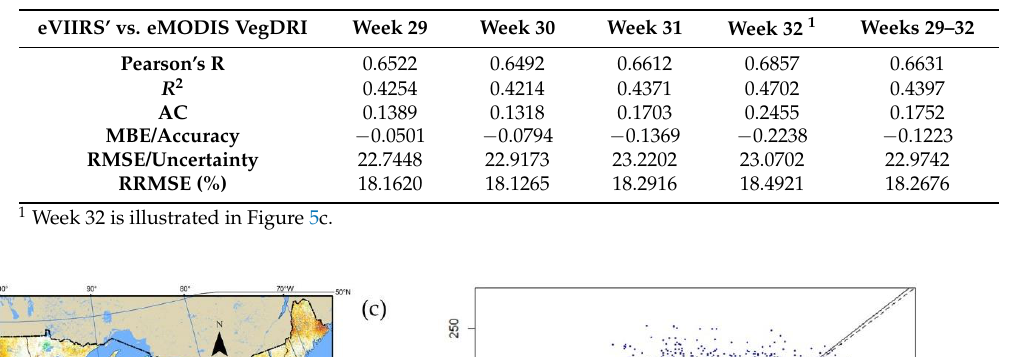
Table 2. Transformed expedited Visible Infrared Imaging Radiometer Suite (eVIIRS’) Vegetation Drought Response Index (VegDRI) and expedited Moderate Resolution Imaging Spectroradiometer (eMODIS) VegDRI comparison statistics.